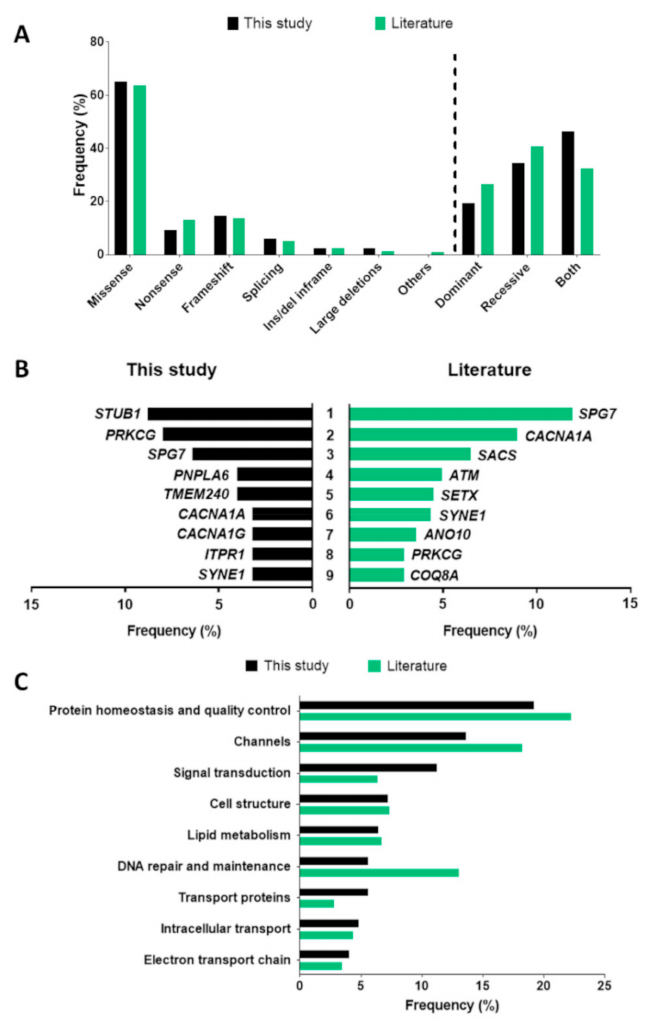
Figure 3. Comparison of molecular findings between this study (black) and literature (green) in terms of ( A ) mutation types and patterns of inheritance, ( B ) most common disease-causing genes, and ( C ) pathways